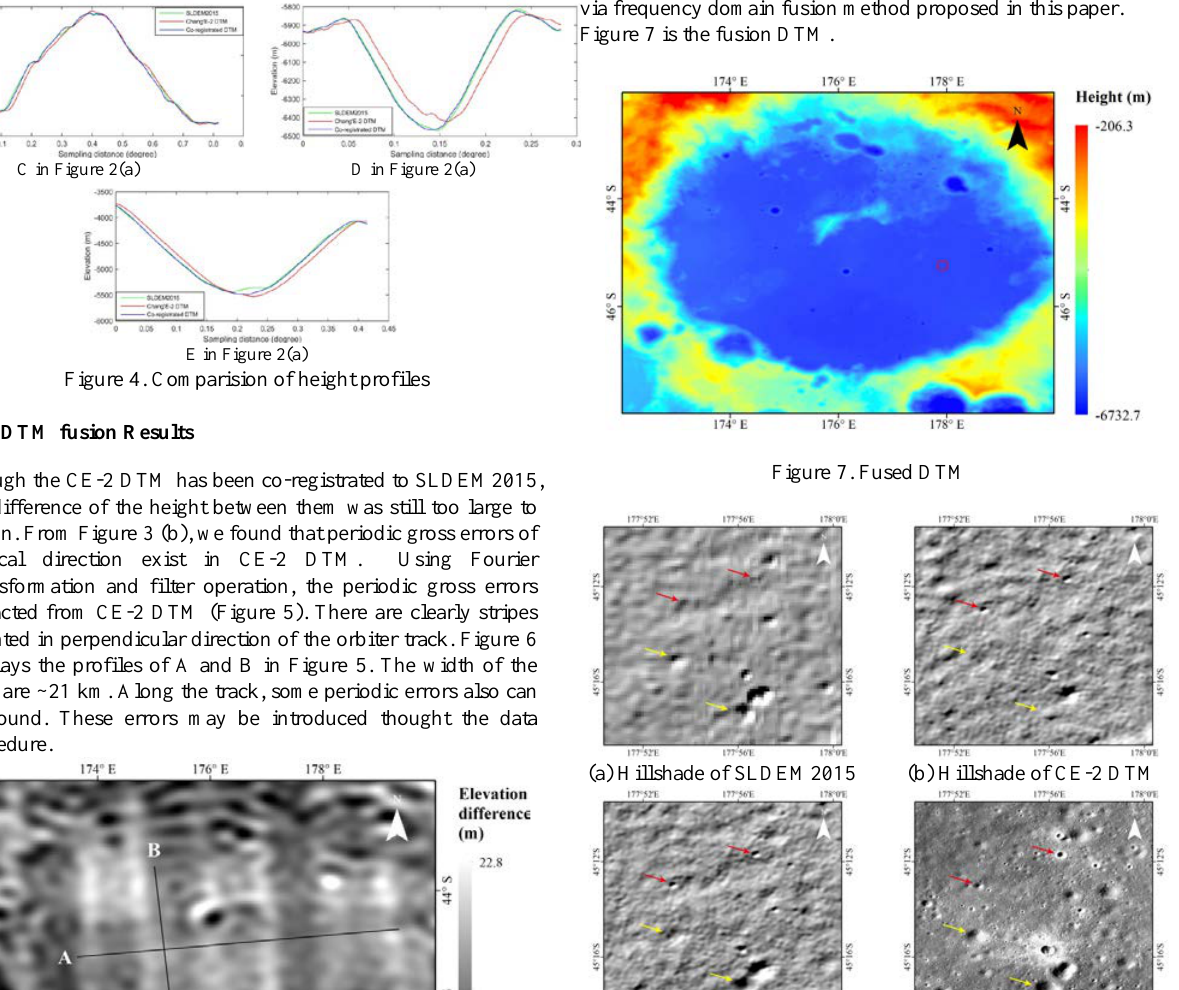
Figure 5. Periodic gross errors extracted from CE-2 DTM.